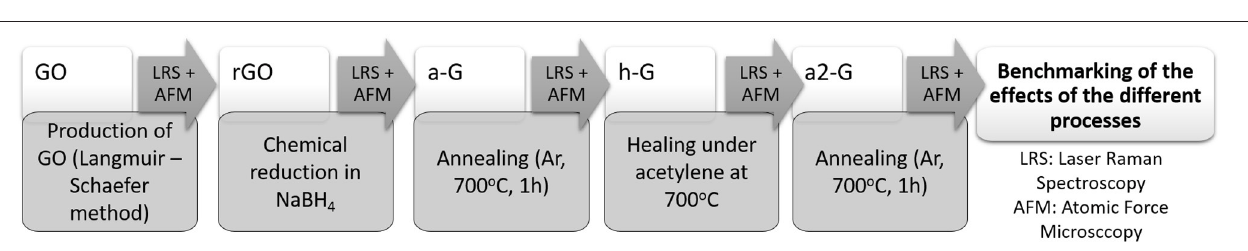
FIGURE 1 | The process flow chart of the current study.